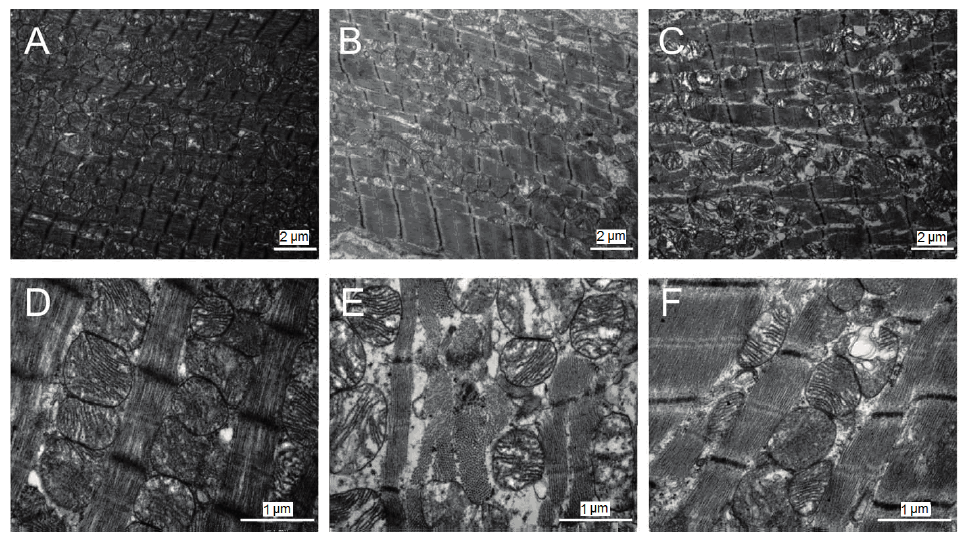
Figure 4. Transmission electron microscopy of myocardium after 20 min of ischemia followed by 60 min of reperfusion in control group ( A , D ), AT1-AA group ( B , E ), and AT1-AA + losartan group ( C , F ). ( A , D ) Normal nuclei and mitochondria in control group; ( B , E ) The mitochondria are swollen, partly disrupted, and contain flocculent densities; ( C , F ) Sarcomeres are moderately relaxed and mitochondria are swollen in AT1-AA + losartan group. Original magnification ( A , B ) 8400×; ( C – F ) 22,500×.